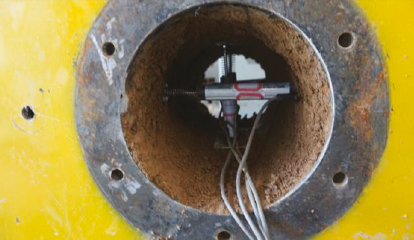
Figure 2: Grouting mesh tube.